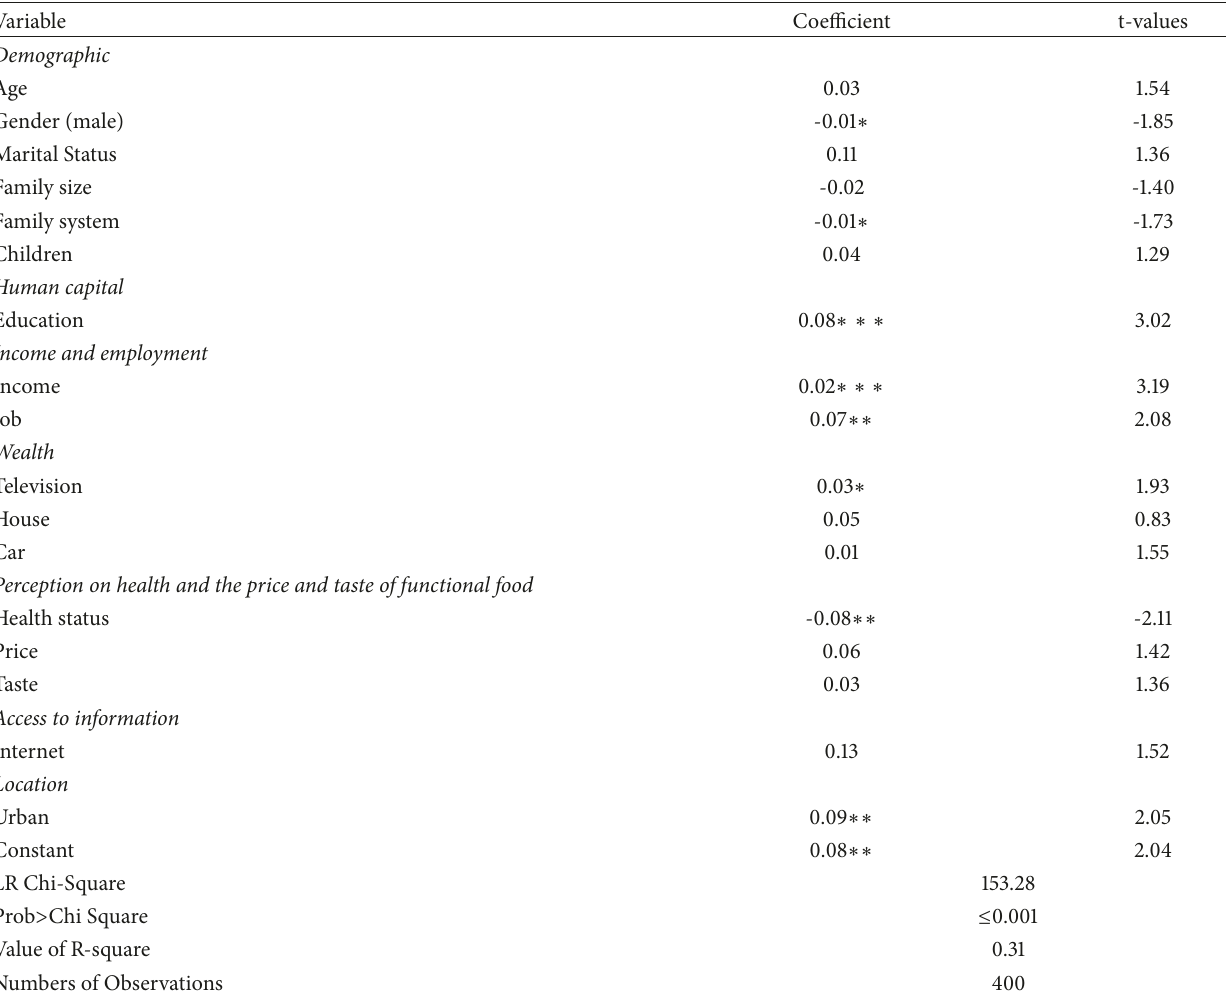
Table 4: Numbers of the functional food items consumed per week (Poisson regression